Question: Write the caption for this figure.
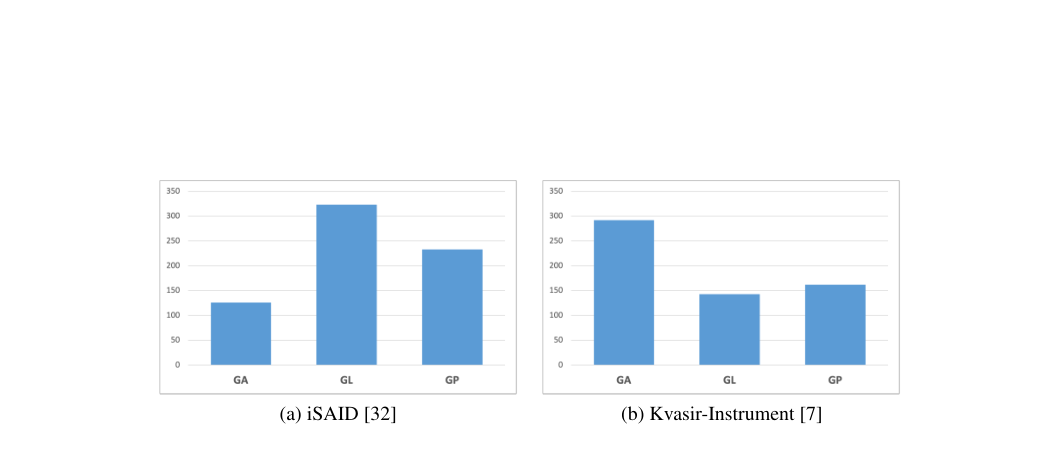
Answer: Number of times each PEFT method is called during inference. Different datasets display distinct patterns